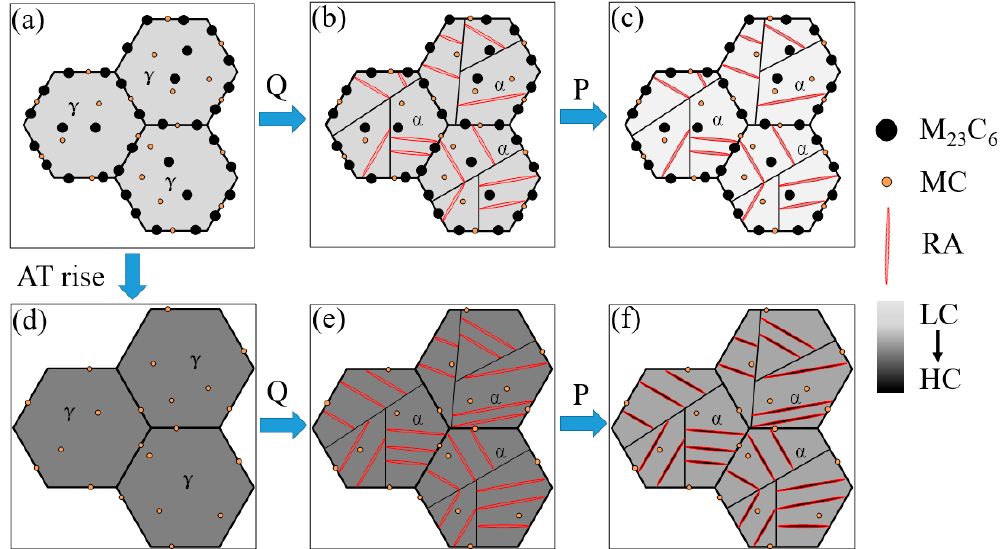
Figure 10. The schematic of the microstructure evolution during the quenching and partitioning at different austenitizing temperatures, ( a , d ) austenitizing, ( b , e ) quenching, ( c , f ) partitioning, where “AT” represents the austenitizing temperature, “LC” and “HC” represent the low and high carbon/chromium content, respectively, and the darker the color is, the higher the content (the chromium content in quenched and partitioned martensite/austenite is identical).